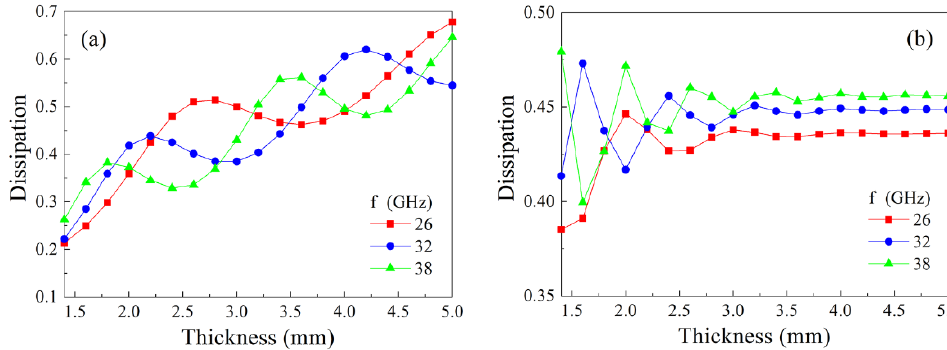
Figure 9. The dependences of microwave dissipation on the thickness of the plate for the composite with 15% ( a ) and 30% ( b ) flakes calculated for several frequencies.